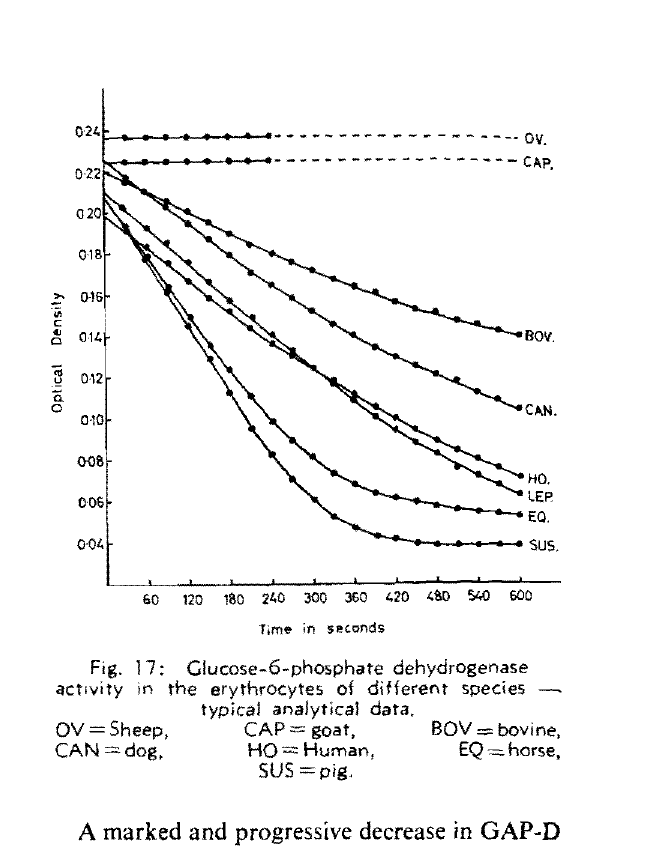
Fig. 17: Glucose-6-phosphate dehydrogenase activity in the erythrocytes oi diHerent species - typical analytical data. OV = Sheep, CAP goat, BOV = bovine, CAN dog, HO= Human, EQ = horse. SUS =pig.